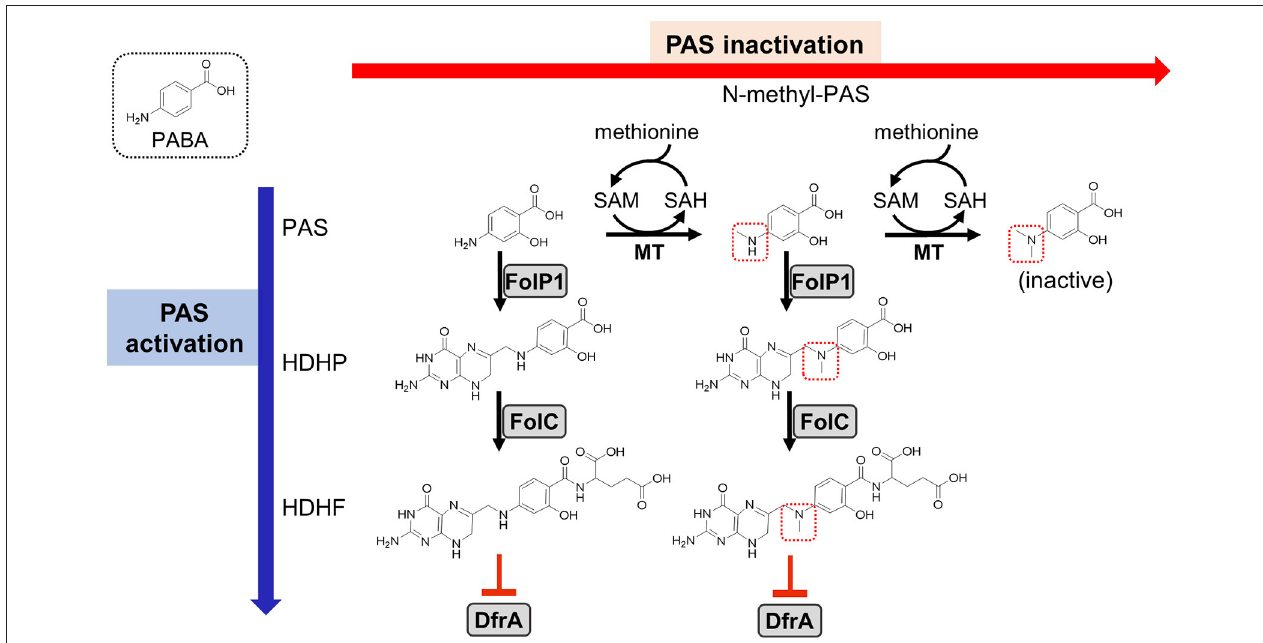
FIGURE 1 | Previously proposed models for PAS activation and methionine-mediated PAS inactivation. As indicated on the left, PAS is an analog of PABA (shown in a dotted box) and is a prodrug that is activated by the M. tuberculosis folate biosynthetic pathway. PAS is incorporated in lieu of PABA by FolP1 and glutamylated by FolC to form the antimetabolite HDHF which inhibits DfrA activity (indicated as red blunted arrows) ( Zheng et al., 2013; Zhao et al., 2014; Minato et al., 2015; Dawadi et al., 2017 ). Previous work has identified N-methyl and N,N -dimethyl PAS species (methyl groups indicated with dotted red boxes) in metabolite extracts from M. tuberculosis treated with PAS ( Chakraborty et al., 2013). As N,N -dimethylation of PAS prevents incorporation by FolP1, the resulting metabolite is inactive (shown on the right). This activity is presumed to be dependent upon an as of yet unidentified SAM-dependent methyltransferase(s). Supplementation with methionine may increase SAM pools, which could be utilized by the methyltransferase(s) to inactivate PAS, thereby conferring resistance. PAS, para -aminosalicylic acid; PABA, para -aminobenzoic acid; HDHP, 2 ′ -hydroxy-7,8-dihydropteroate; HDHF, 2 ′ -hydroxy-7,8-dihydrofolate; FolP1, dihydropteroate synthase; FolC, dihydrofolate synthase; DfrA, dihydrofolate reductase; MT, methyltransferase; SAM, S- adenosyl methionine; SAH, S -adenosyl homocysteine.